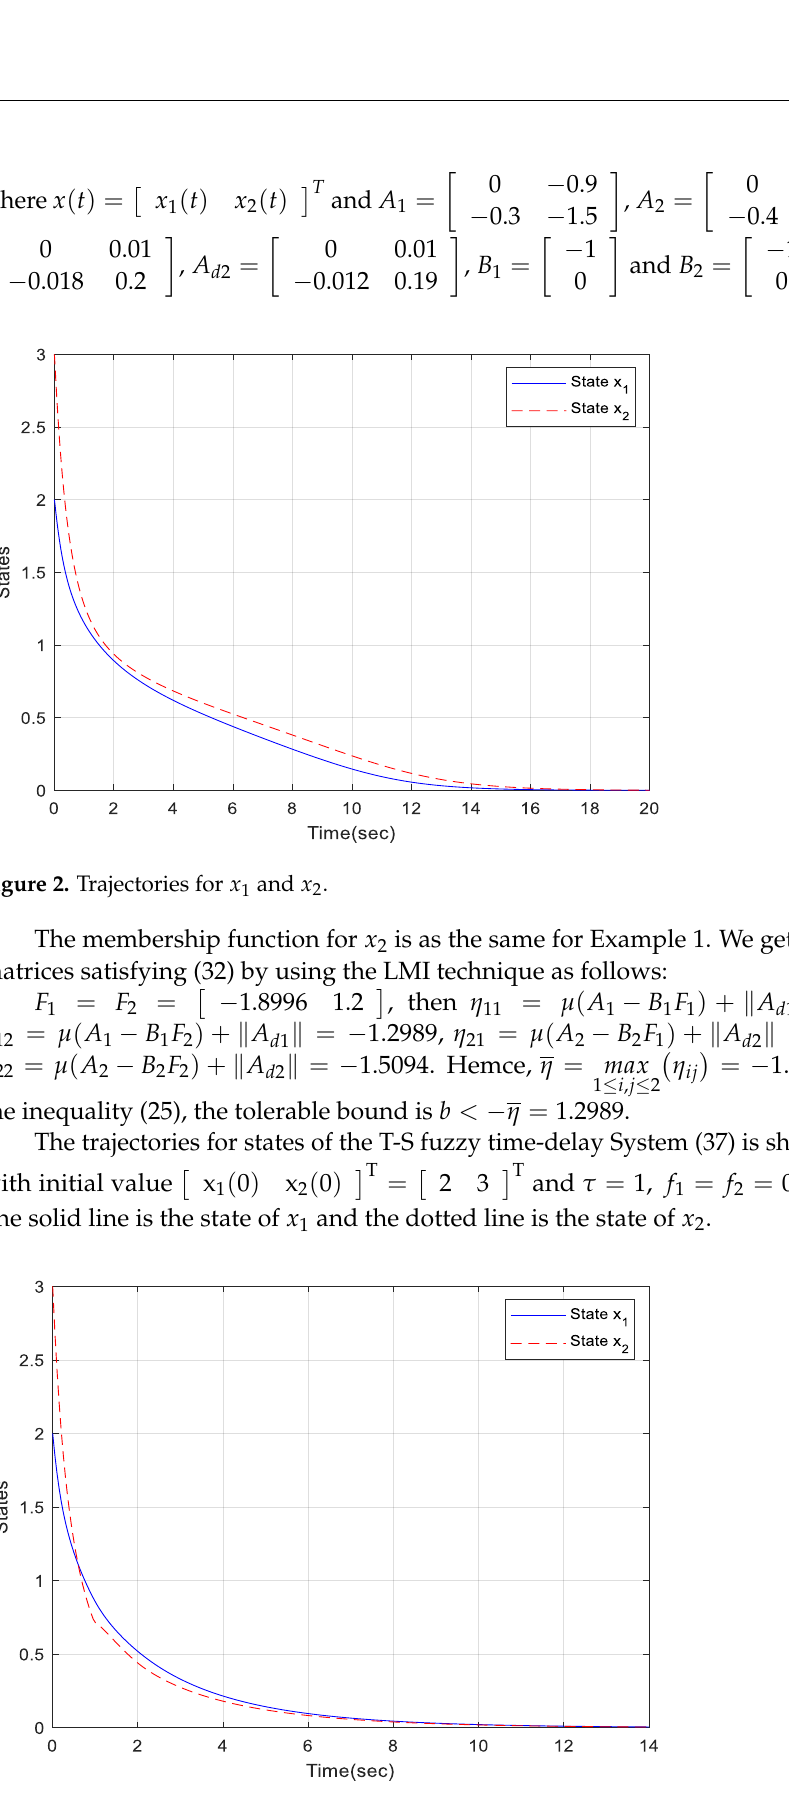
Figure 3. Trajectories for 𝑥 1 and 𝑥 2 .